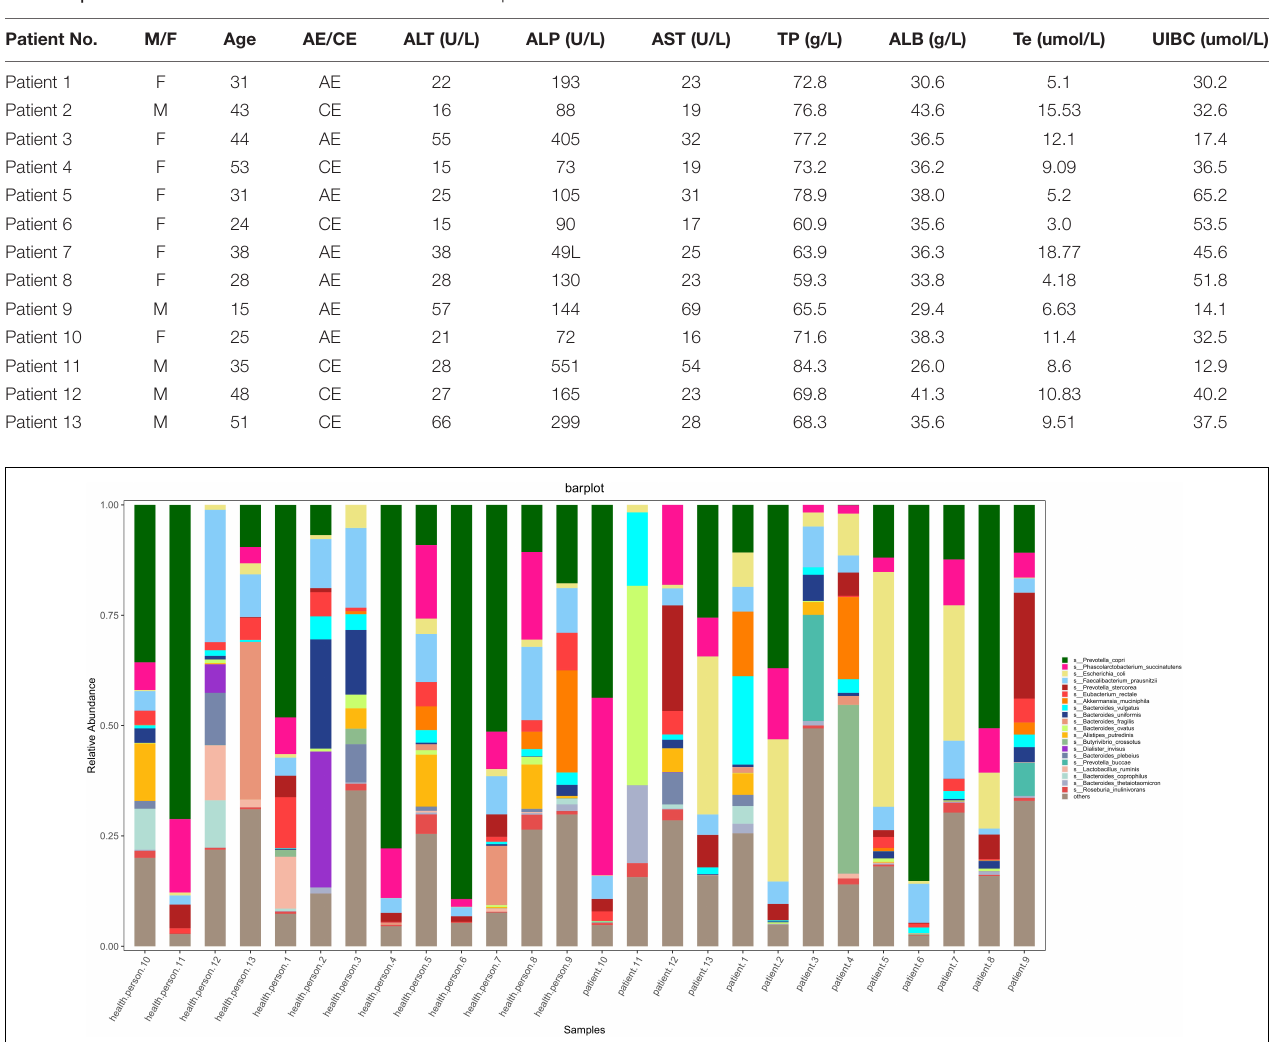
TABLE 1 | General condition and clinical liver function index of 13 patients with echinococcosis. Patient No.